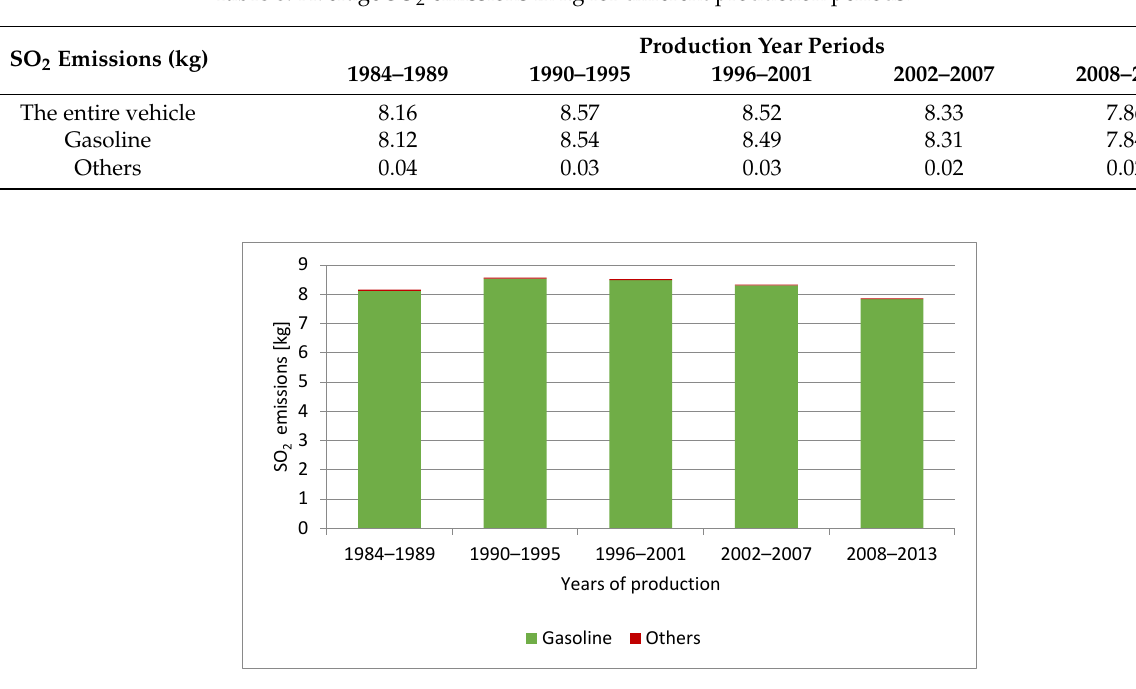
Table 8. Average SO 2 emissions in kg for different production periods.